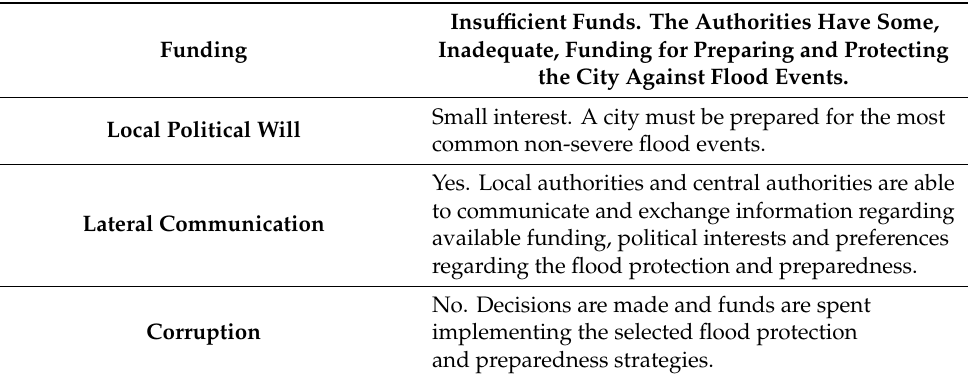
Table 2. Socio-economic